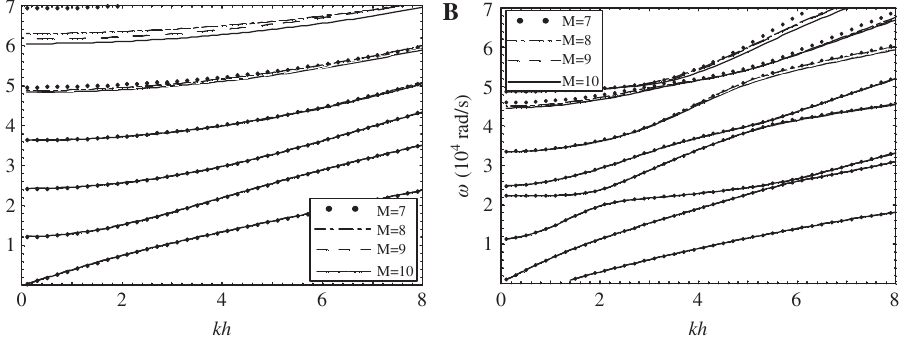
Figure 1 Circumferential wave dispersion curves for the linearly graded cylindrical plate under radial initial stress P = -20 GPa for various M : (A) circumferential SH wave, (B) circumferential Lamb-like wave.